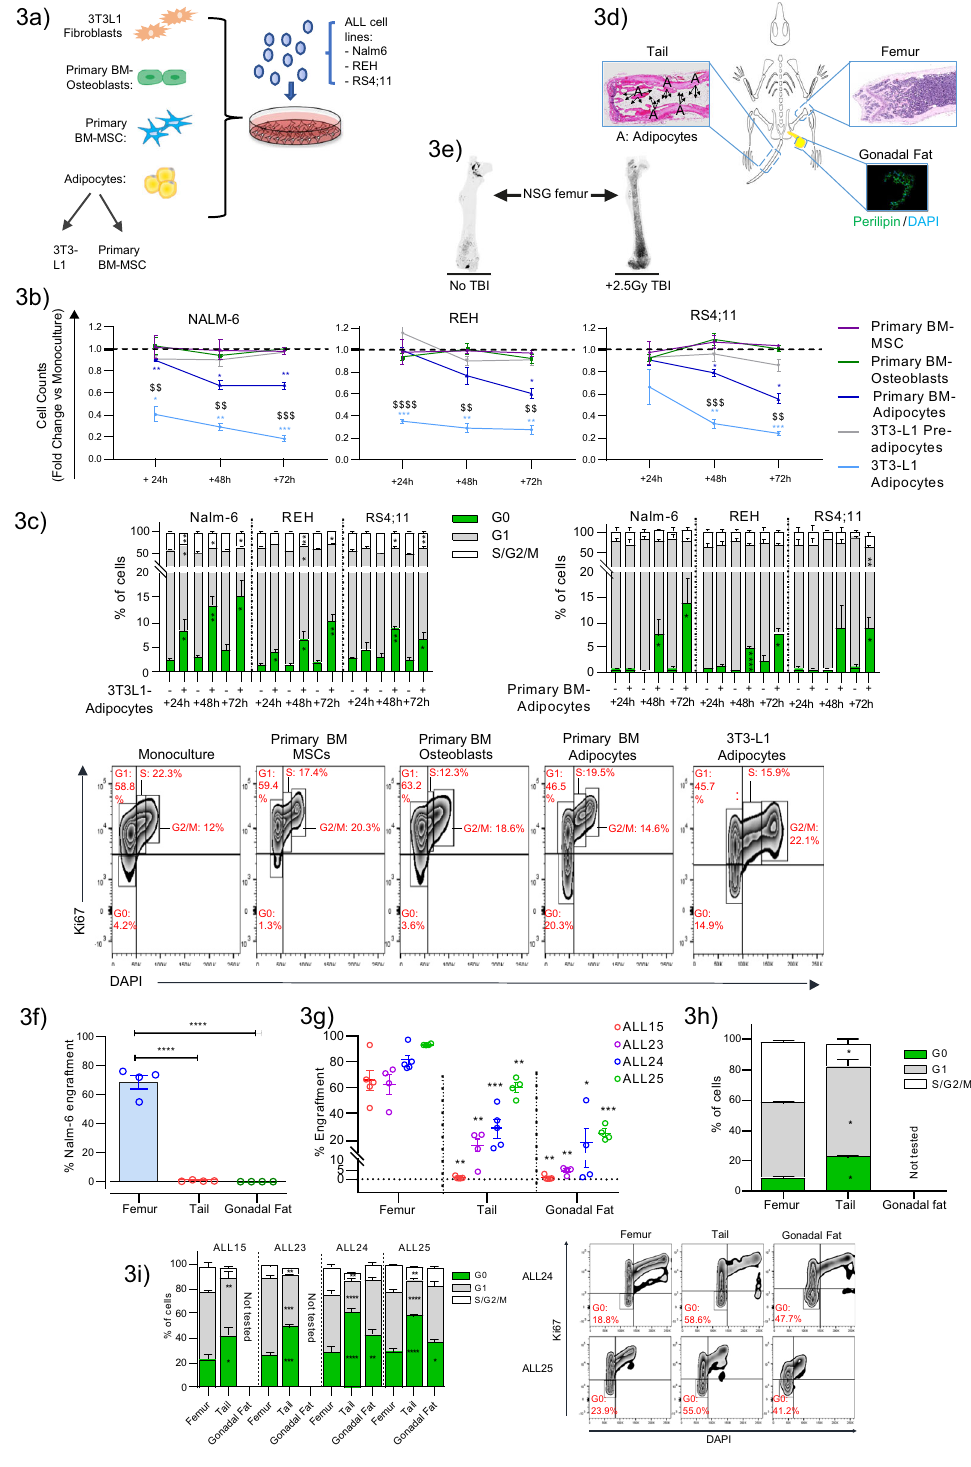
Gene expression pro fi les of adipocyte-cultured Nalm-6 cells at + 24 h assessed by RNAseq indicated predominantly low- magnitude changes (Fig. 4c, Supplementary Fig. 4l, m) with the difference in the adipocyte imprinted Nalm-6 transcriptome (adjusted p -value < 0.05) de fi ned by only 547 genes, of which only a low number of genes ( n = 50) met conventional DEG thresholds of log 2 FC ≥ 1 or log 2 FC ≤ − 1.GSEA revealed few overrepresented pathways (Fig. 4d), namely, glycolysis ( p- value <